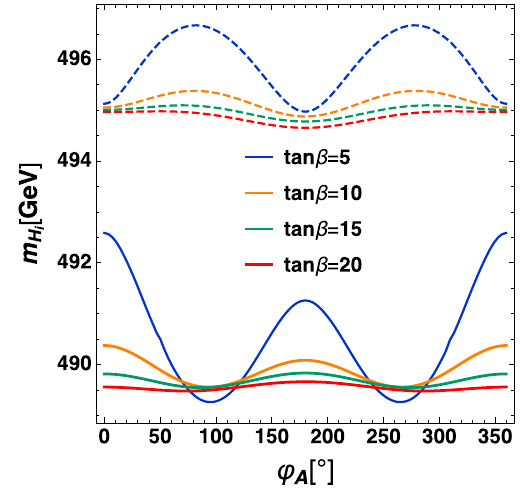
Fig. 9 Thedependence ofthemassofthesecondlightestandtheheav- iest Higgs boson on the phase ϕ A is shown for the parameter scenario M s = 30 TeV, M H + = 500 GeV, | A | = | μ | = 3 M s , ϕ M The solid lines correspond to the mass of the second lightest Higgs boson, m H , and the dashed lines to the mass of the heaviest Higgs 2 boson, m H